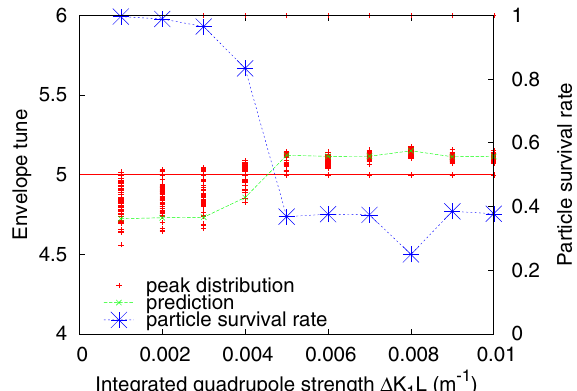
FIG. 8. Peak distribution and the particle survival rate with different quadrupole errors (injection turn ¼ 30 ).